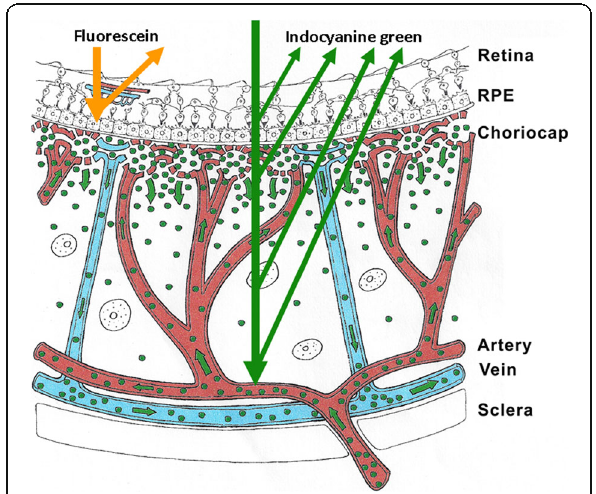
Fig. 1 Cartoon on optical characteristics explaining the differences between fluorescein (FA) and indocyanine green angiography (ICGA). FA is only able to analyse the fluorescence coming from the retina as the RPE is blocking visible light fluorescence, while ICGA is able to analyse retinal and choroidal near-infrared fluorescence which is not blocked by the RPE. Note, at the level of the choriocapillaris, the schematic drawing shows the physiological egression of the ICG macromolecular complex from the fenestrated choriocapillaris impregnating the choroidal stroma (see Fig. 2), determining the intermediate and late angiographic phases that